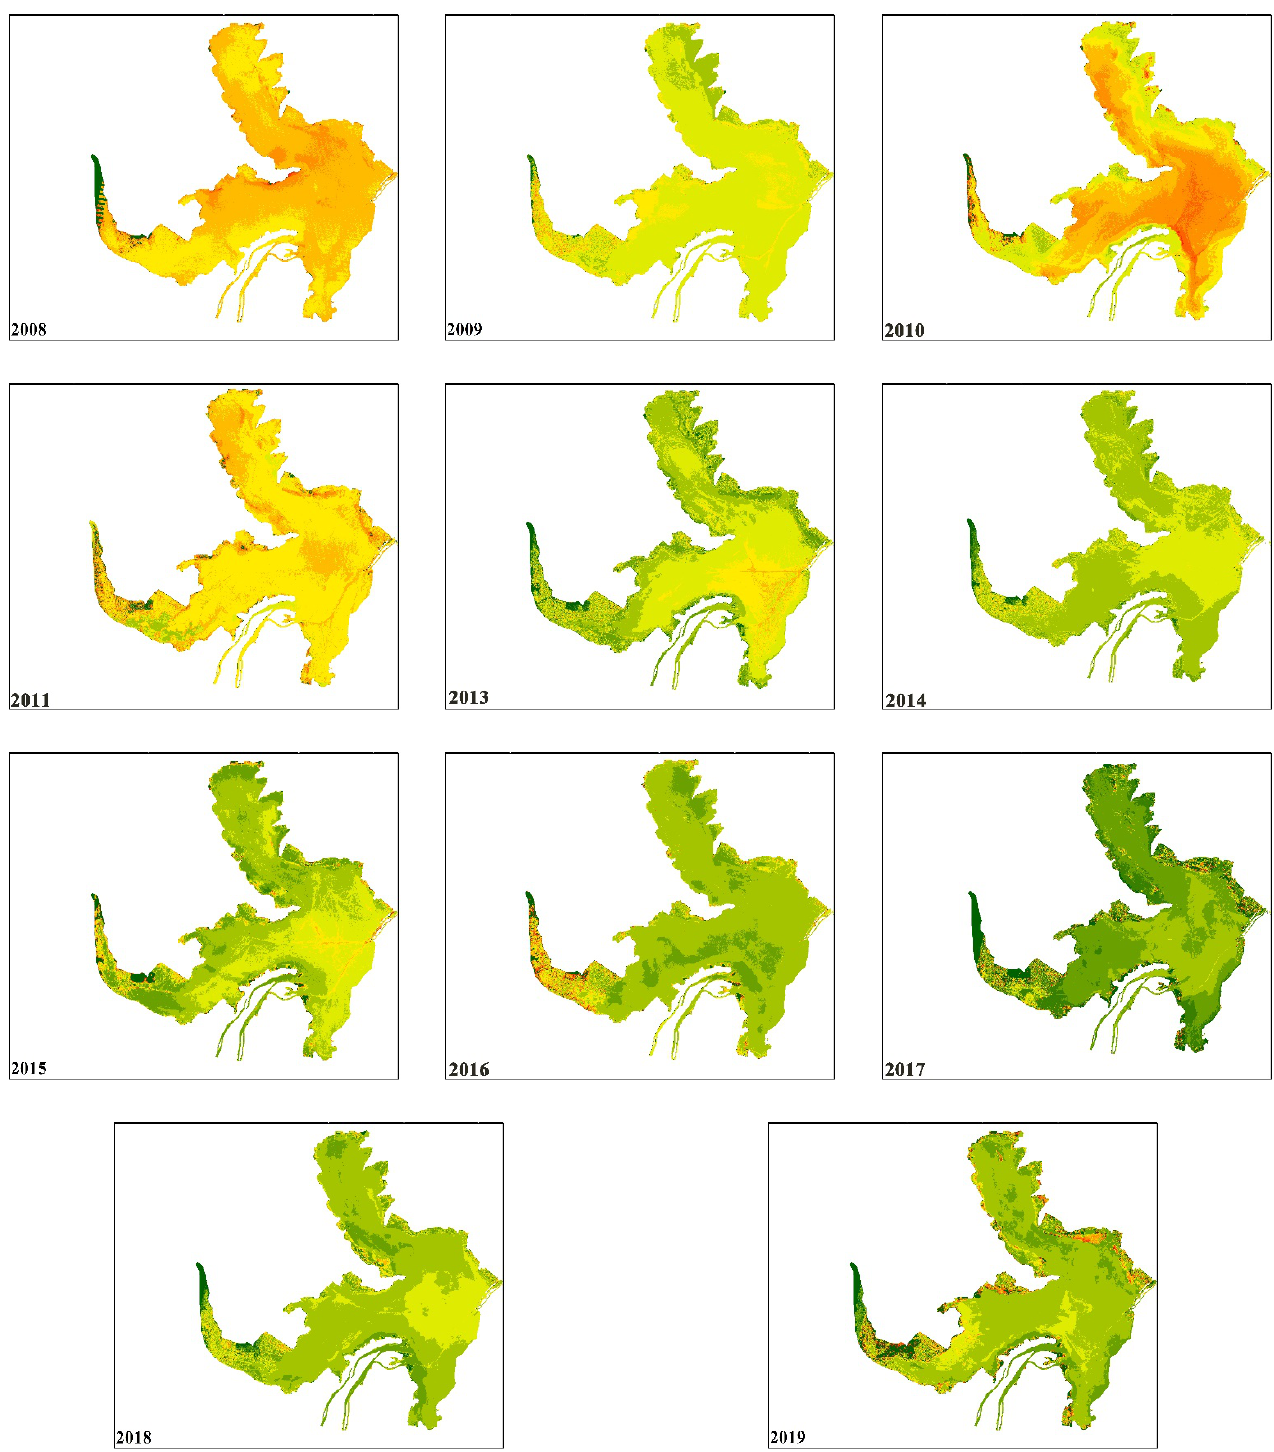
Figure 6. Inter-annual changes in the TSM concentration in the Hongze Lake from 1984 to 2019. The concentration change trends for the three bays were relatively consistent in Fig- ure 7. From 1984 to 2019, the concentration of TSM in the Huaihe Bay was the highest. It is worth noting that the higher concentrations of TSM in the Huaihe Bay often extend from the estuary of the Huai River to the outside. The individual pictures show that a line of high TSM concentration extends from the Huaihe Bay to the Hongze District. From 1984